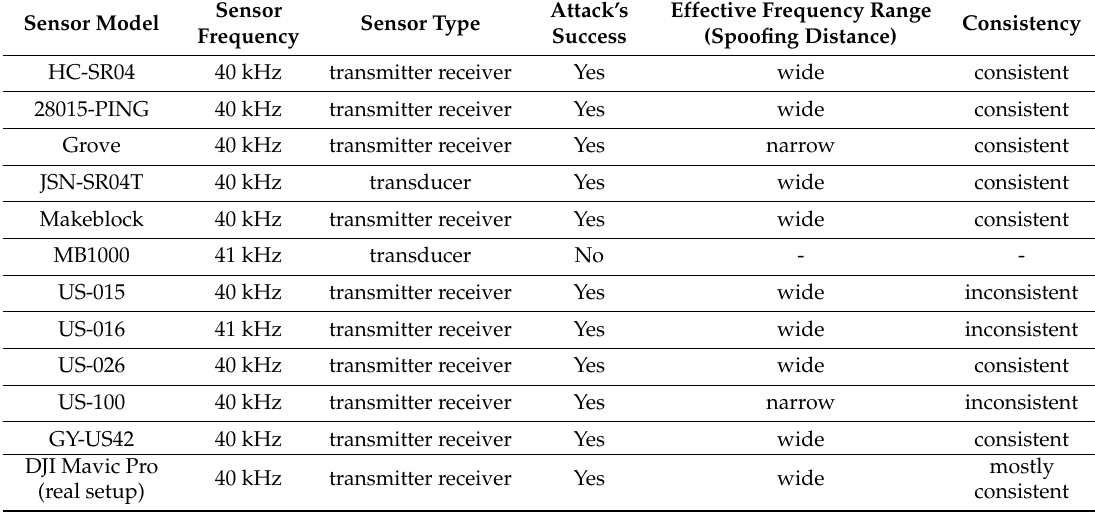
Table 2. The results of the attack on different sensor models. We present the sensor model, the frequency at which the sensor operates, the type of the sensor (transmitter/receiver or transducer), an indication of whether the attack was successful or not, the spoofing distance, and finally, whether the attack is consistent (i.e.,